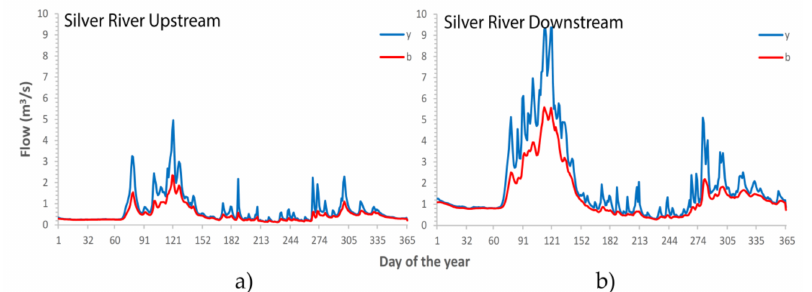
Figure 5. Mean daily streamflow (y) and baseflow (b) hydrographs for Silver River Upstream ( a ) and Silver River Downstream ( b ) gages. Note the distinct “fall bump” in baseflow starting around Day of the Year